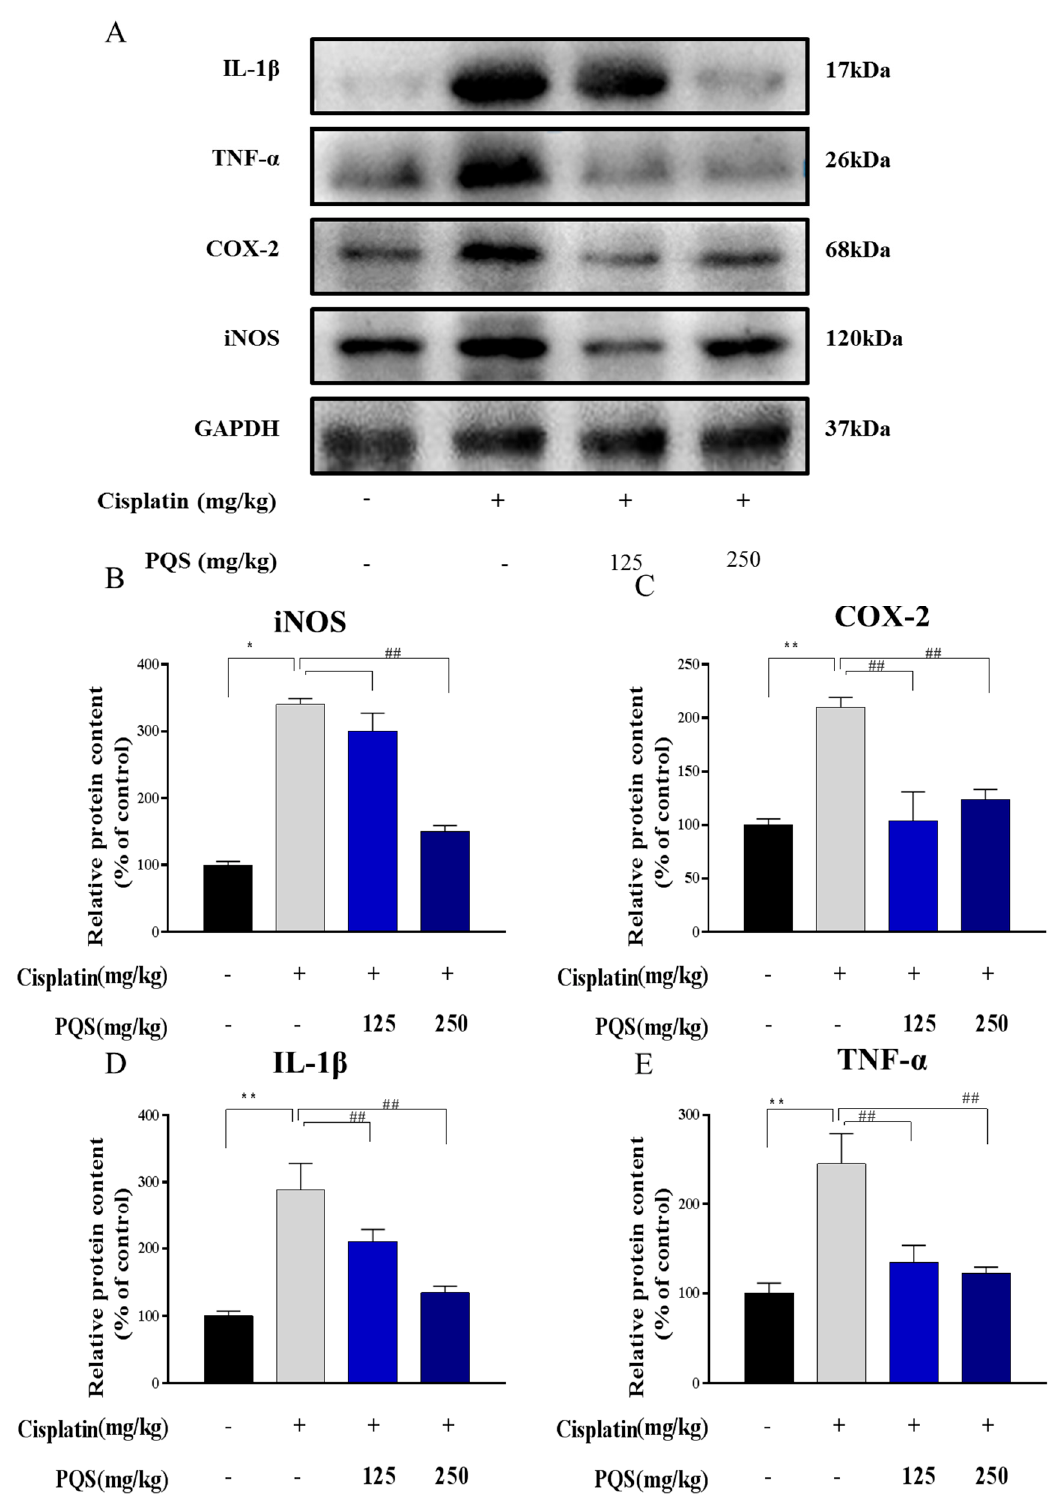
Figure 5. The expression of iNOS, COX-2, TNF- α and IL-1 β were measured by western blotting analysis ( A ). Quantitative analysis of scanning densitometry for iNOS ( B ); COX-2 ( C ); IL-1 β ( D ); TNF- α ( E ). All data were expressed as mean ± S.D. * p < 0.05 or ** p < 0.01 comparing with normal group. ## p < 0.01 comparing with cisplatin group.